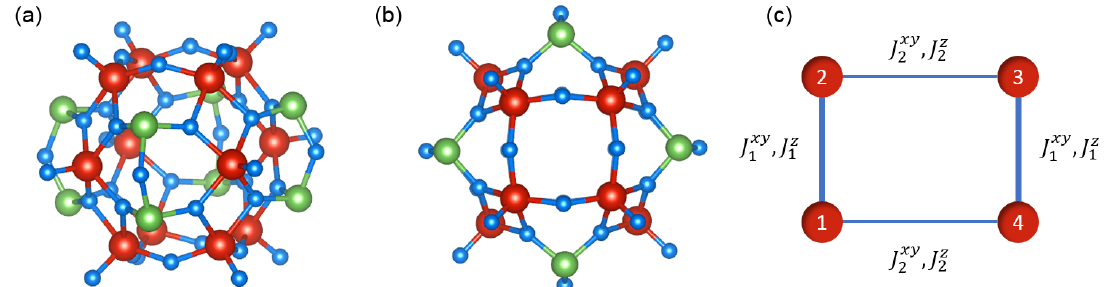
Figure 1. A schematic side view ( a ) and top view ( b ) of the V12 cluster—V atoms marked with red, As atoms with green, O atoms with blue, without the water molecule encapsulated inside for clarity; ( c ) a central tetramer composed of V atoms with spin labels and with the spin-spin exchange couplings marked with lines. The schemes ( a , b ) were prepared using VESTA [57] on the basis of crystallographic data for V12 acquired from